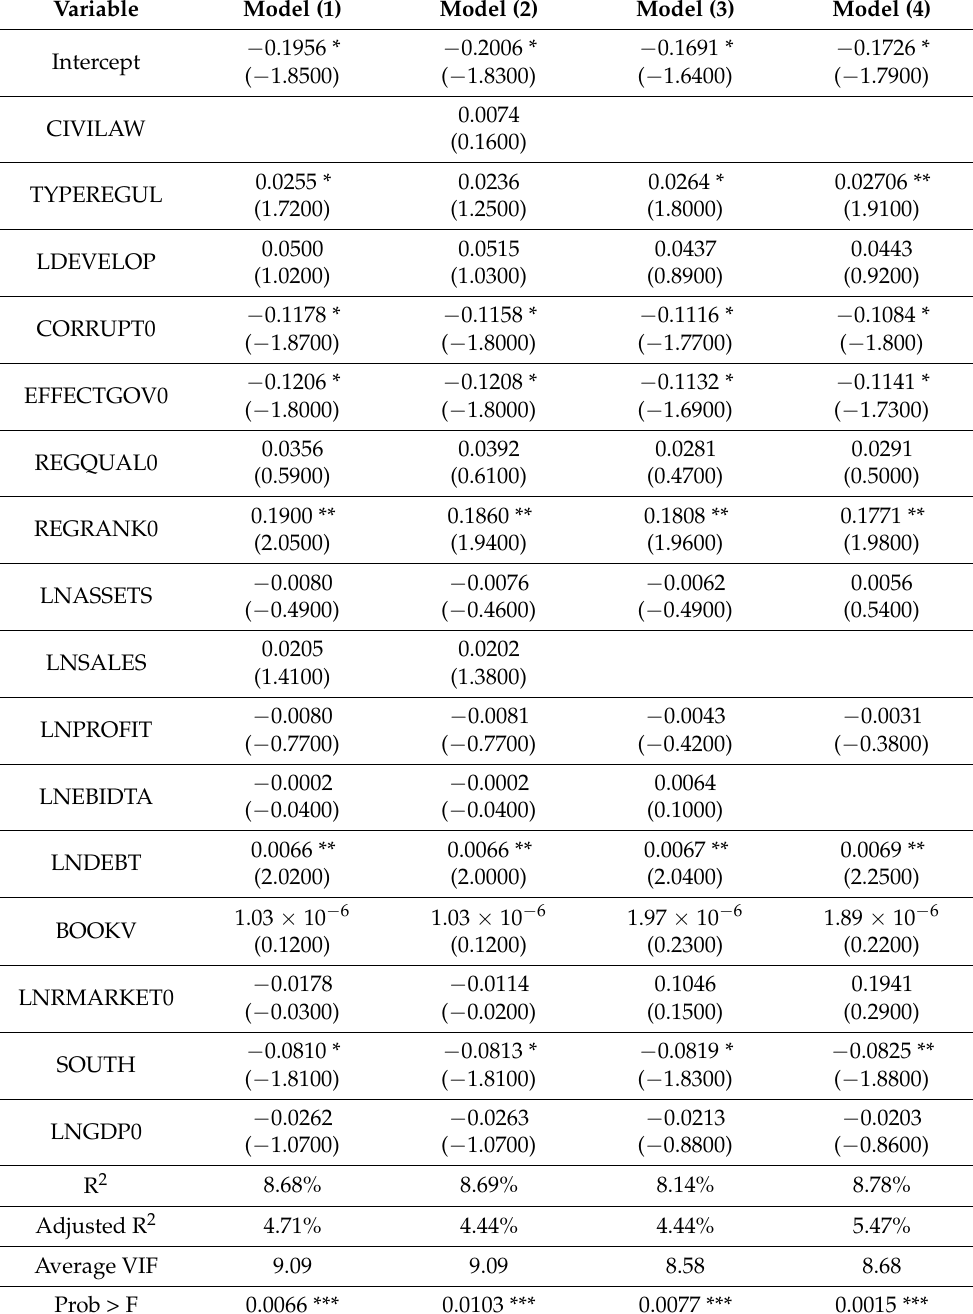
Table 4. Initial return—LNRI—results